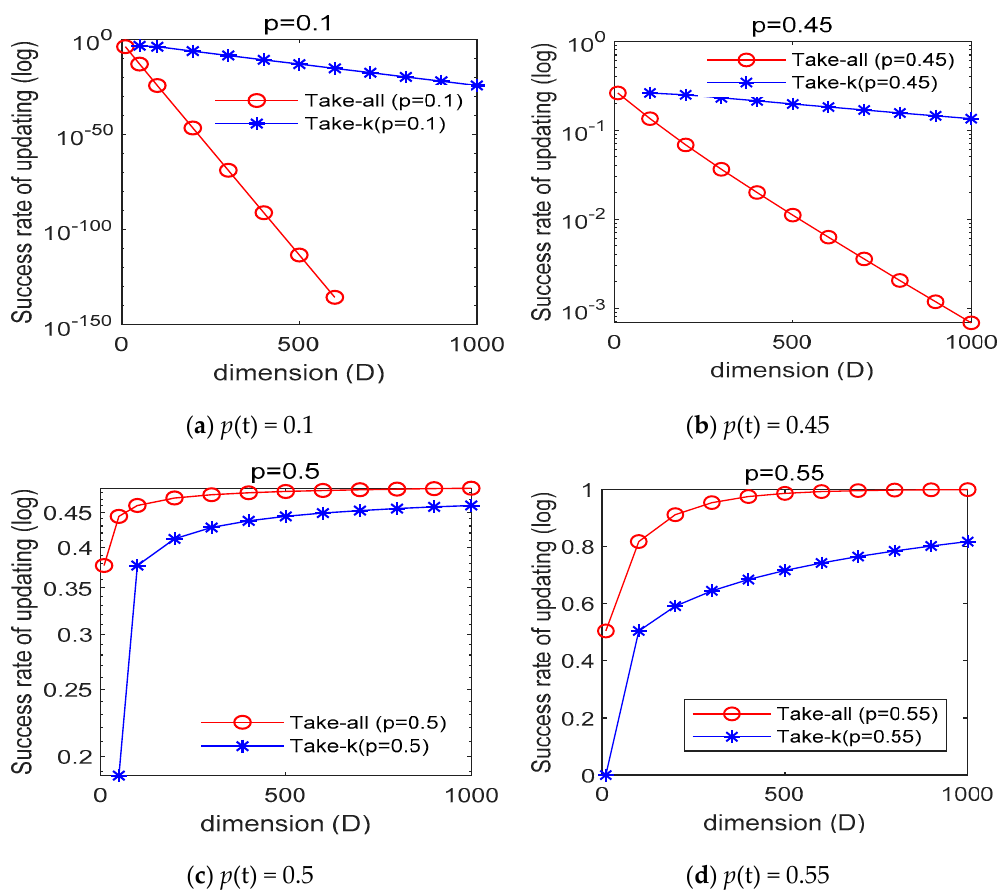
Figure 2. Comparison of the take-k and take-all strategies (k = 0.1 D ). ( a ) p (t) = 0.1; ( b ) p (t) = 0.45; ( c ) p (t) = 0.5; ( d ) p (t) = 0.55.